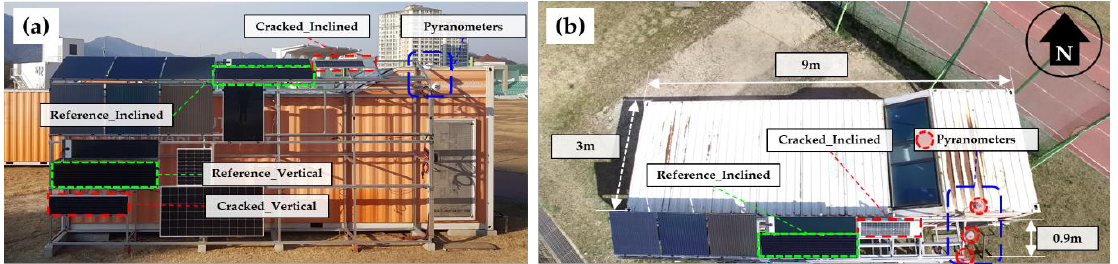
Figure 4. Experimental facility for testing PV systems: ( a ) front view; ( b ) top view.